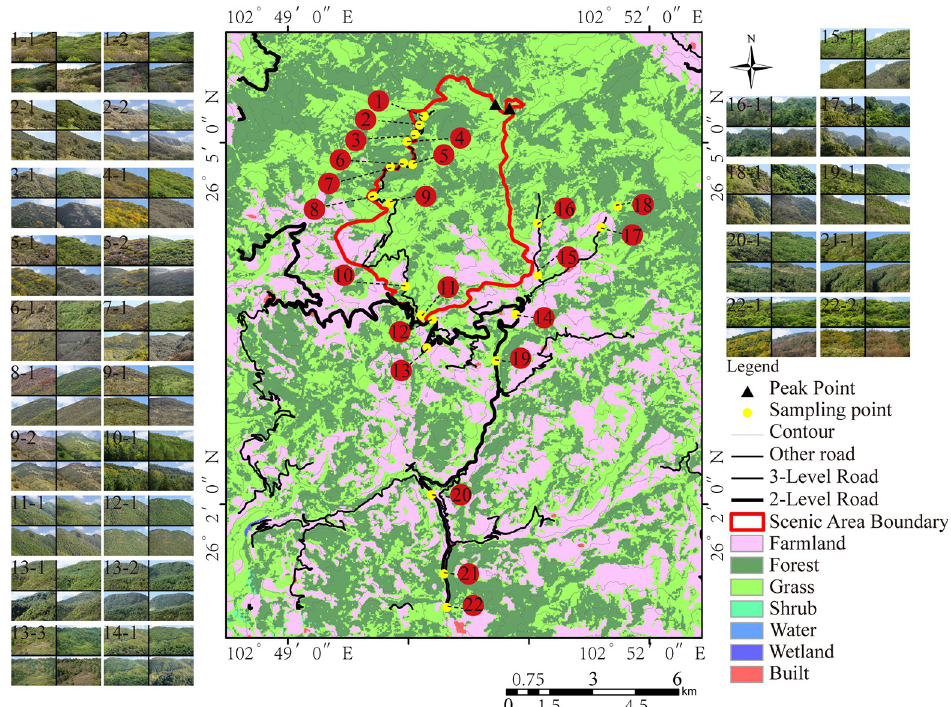
Fig 1. Distribution of sampling points. The land use of Jiaozi Mountain in 2020, with a spatial resolution of 30 x 30, can be divided into seven types: farmland, forest, grassland, shrubland, wetland, water body and built-up area, according to Global 30 (http://www.globallandcover.com/). The distribution vector data of roads in Jiaozi Mountain in 2015 came from the National Catalogue Service for Geographic Information (https://www.webmap.cn.